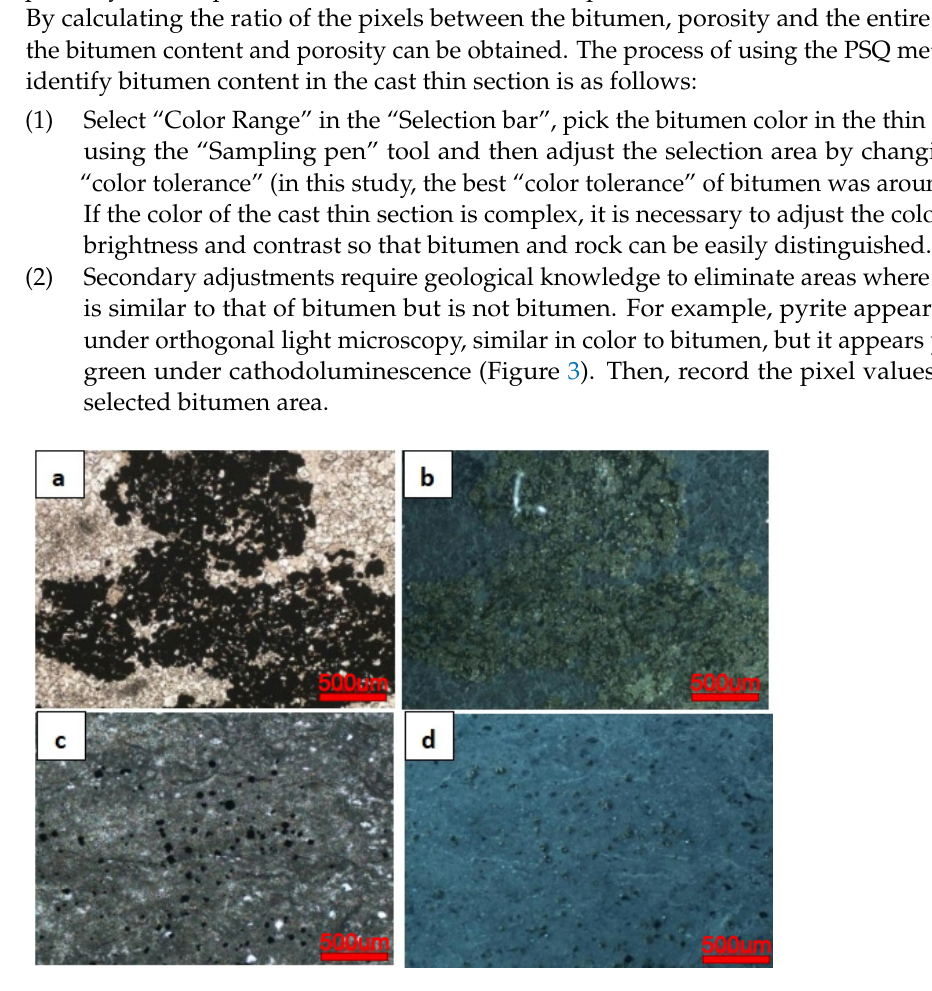
Figure 3. Microscopic identification characteristics of pyrite in Well Shutan 1: ( a , c ) orthogonal optical images; ( b , d ) cathodoluminescence images.